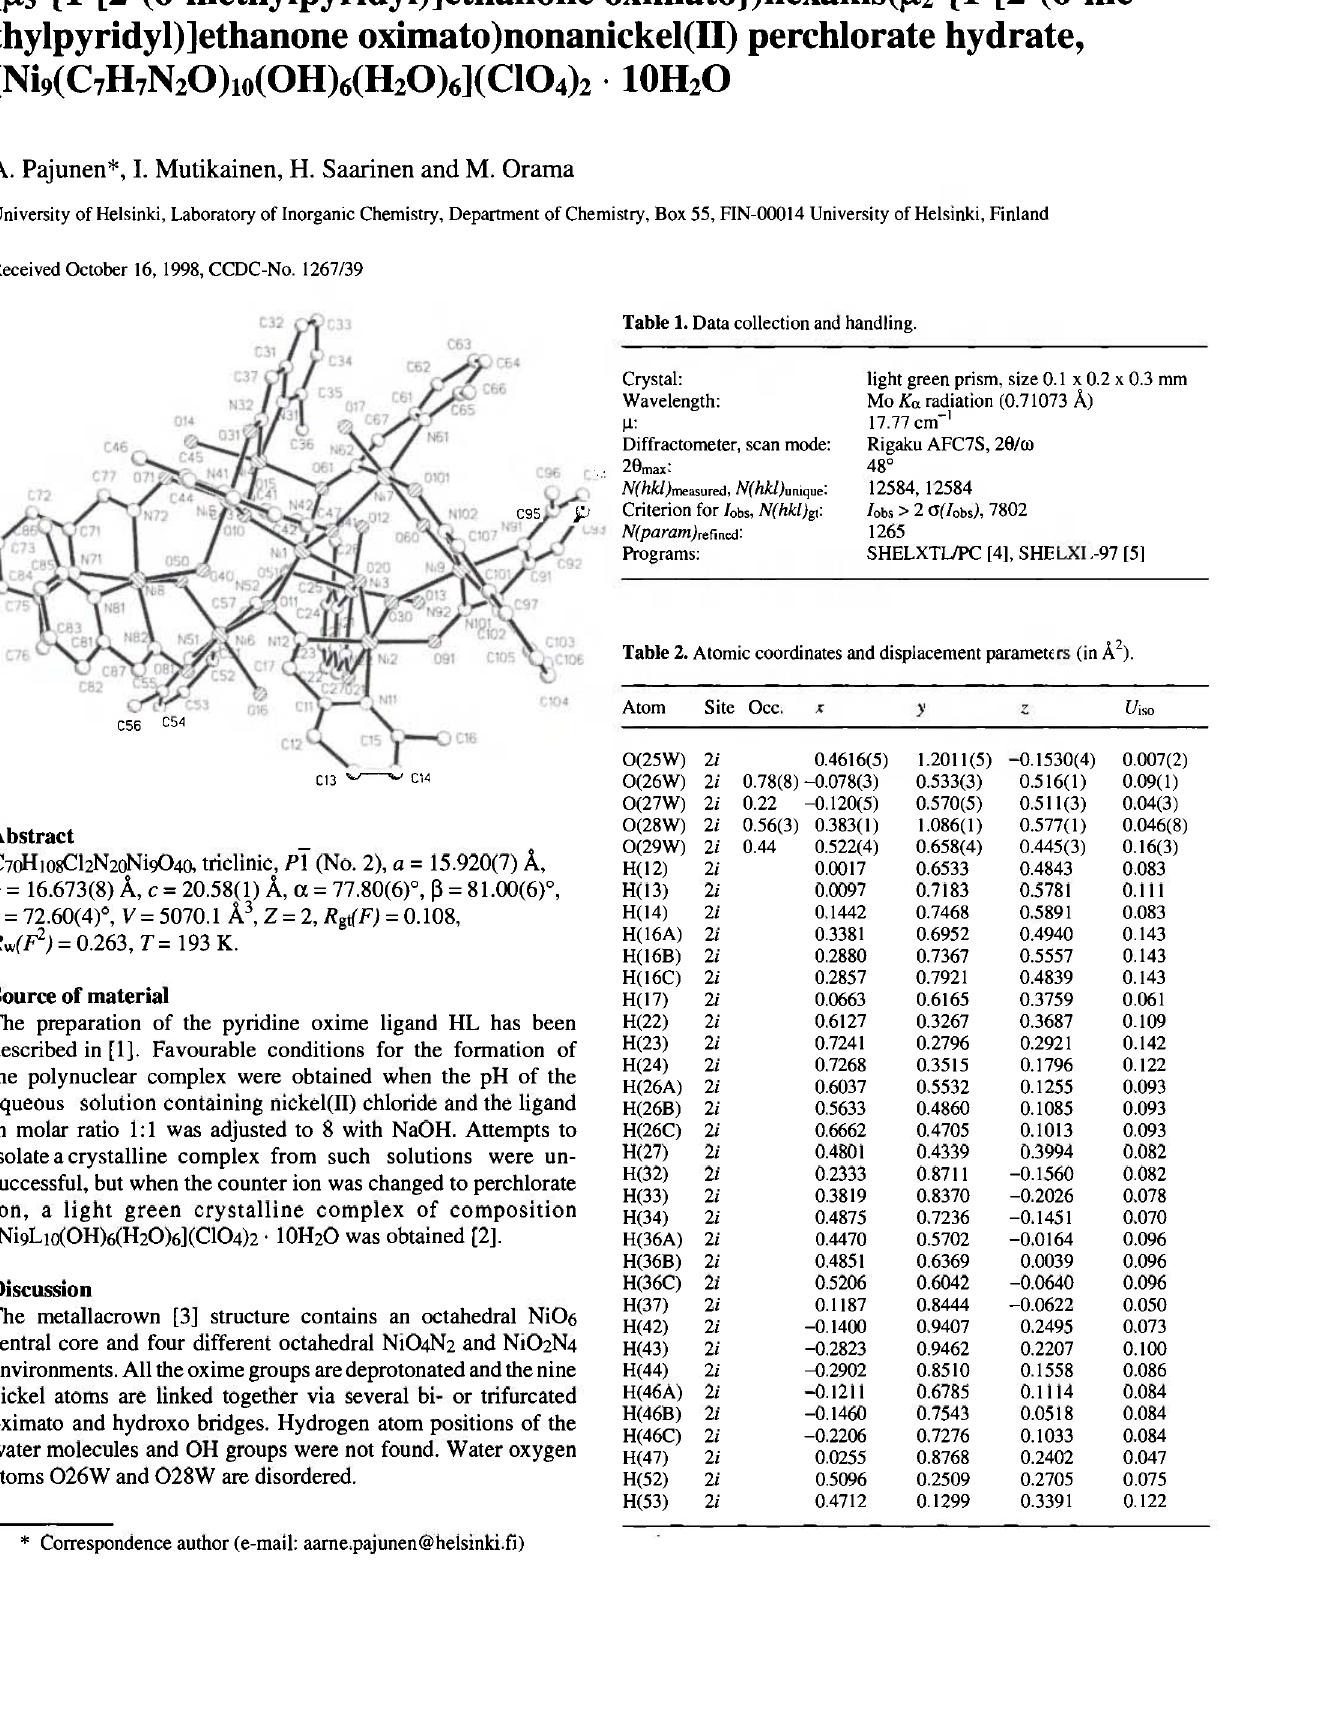
Table 1. Data collection and handling. Crystal: Wavelength: